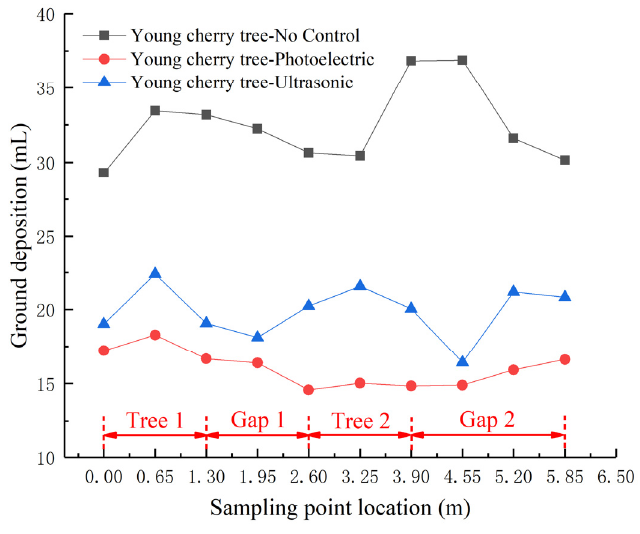
Figure 12. Distributions of ground deposition at the gap and tree positions of the young cherry trees.